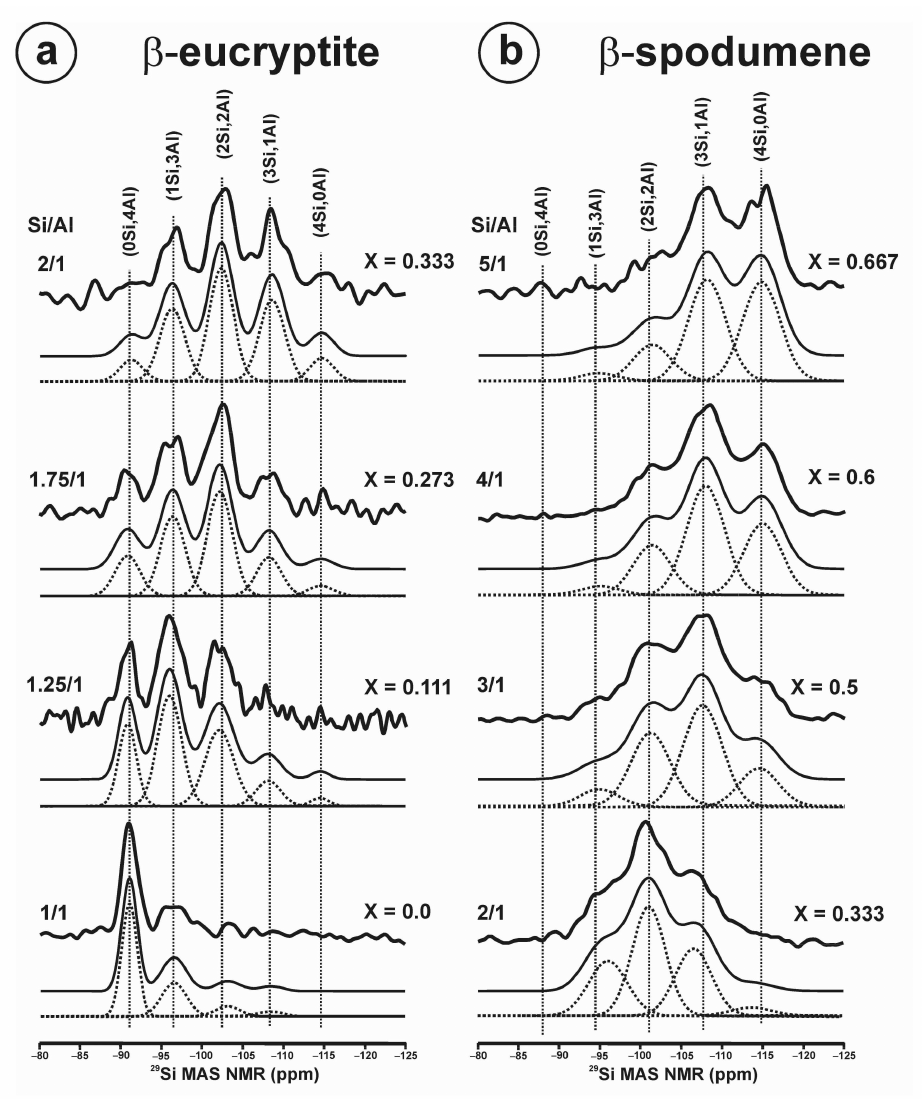
Figure 4. The 29 Si spectra of β -eucryptite in ( a ), and β -spodumene in ( b ) for different x values. The position and intensity of the deconvolutions are in Table 4. The mineral species called “virgilite” corresponds to LiAlSi 2 O 6 composition for Si/Al = 2/1 with β -eucryptite